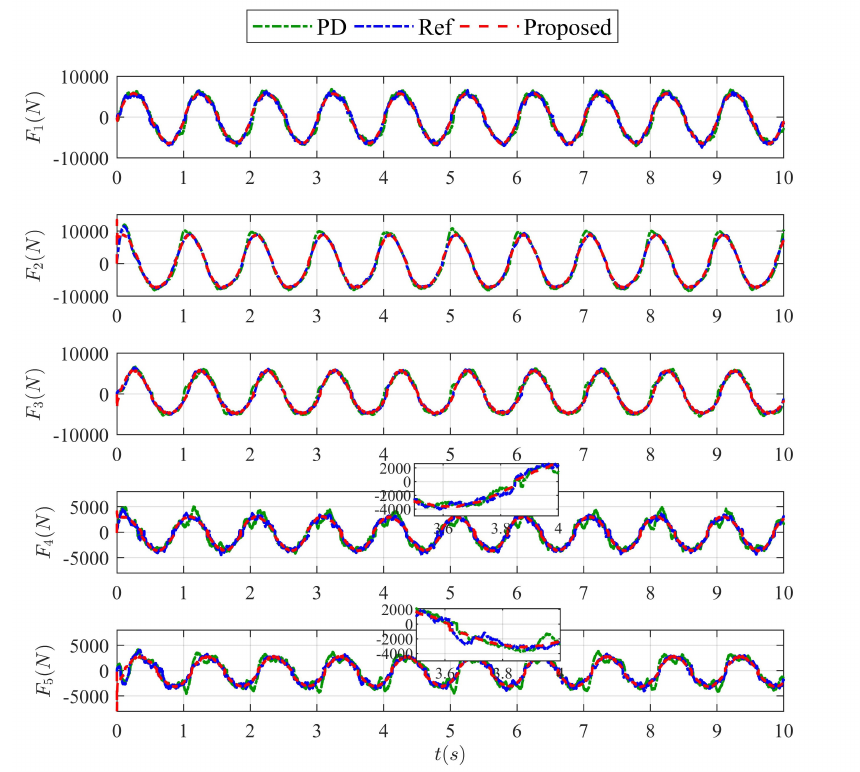
Figure 13. Control forces under different controllers for case